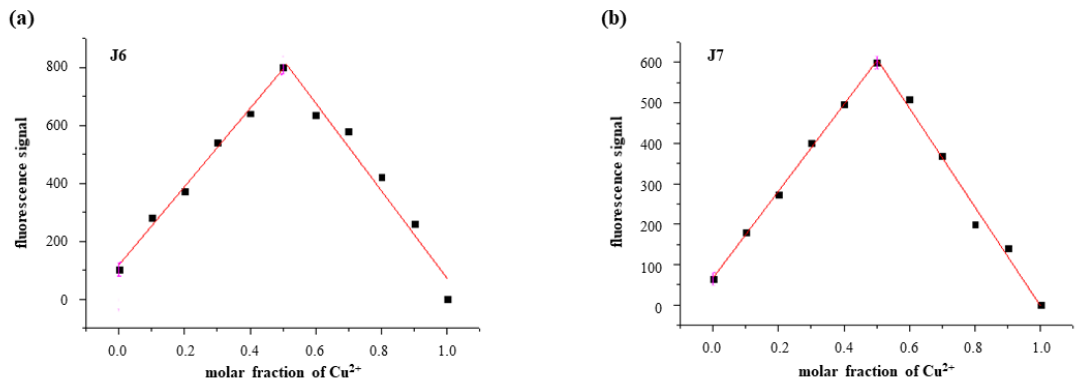
Figure 6. Association stoichiometry of ( a ) J6-Cu 2+ and ( b ) J7-Cu 2+ . As for J7, the linear relationship at 560 nm towards [Cu 2+ ] in the range of 0~6 µ mol L − 1 (Figure 5b, inset) based on Stern-Volmer Equation could be expressed as y = 0.2762x +